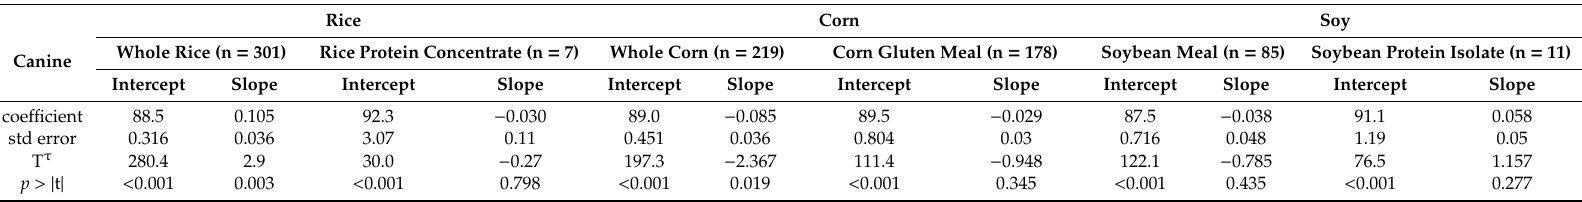
Table 6. Relationship between true protein digestibility and the amount of the dietary protein contributed by whole grains or protein fractions (expressed as dry matter) in canine foods.